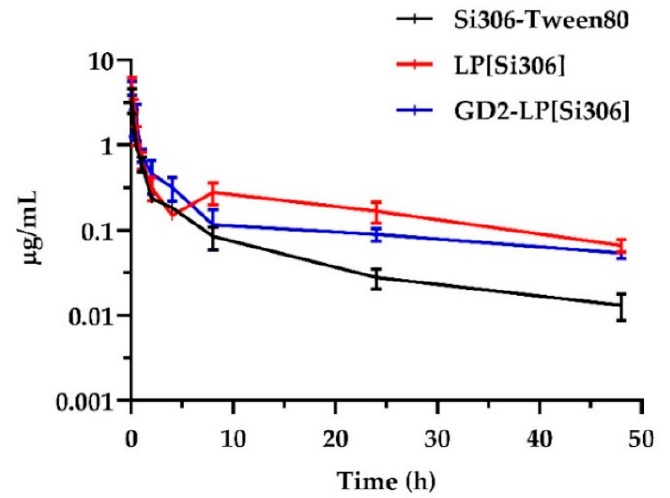
Figure 5. Pharmacokinetic profiles of Si306 in vivo. Plasma concentration-time curves (mean ± S.E.M., n = 5) in healthy mice, after i.v. administration of a single dose of 5 mg/kg Si306, either free (Si306-Tween80) or encapsulated into untargeted and GD2-targeted liposomes (LP[Si306] and GD2-LP[Si306], respectively). The plasma concentration in the y-axis is expressed as log 10 scale.